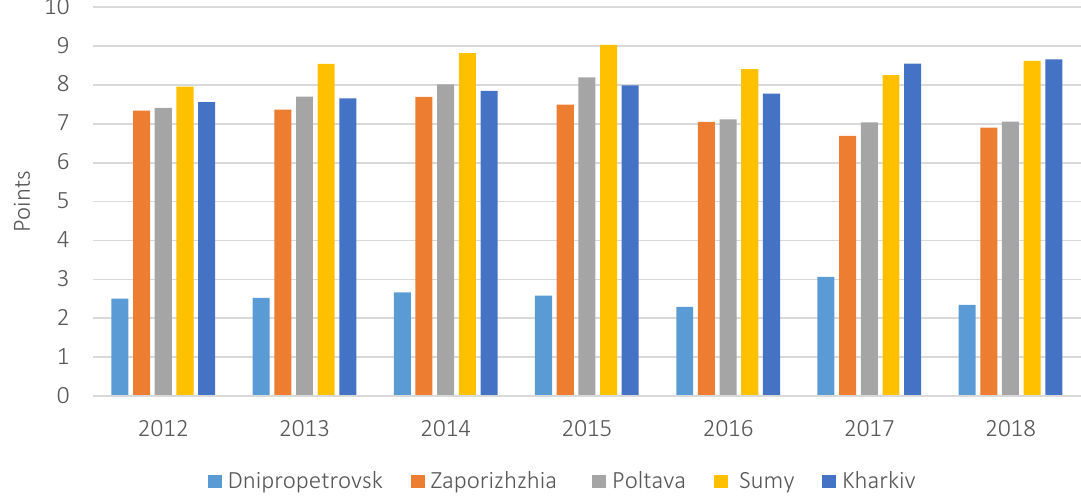
Figure 2. Integral index of level of socio-ecological development of